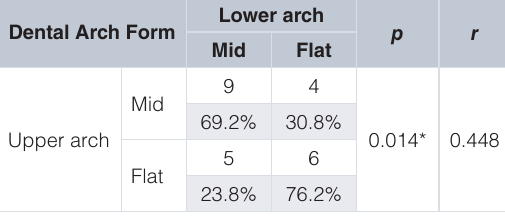
Statistically significant difference ( p